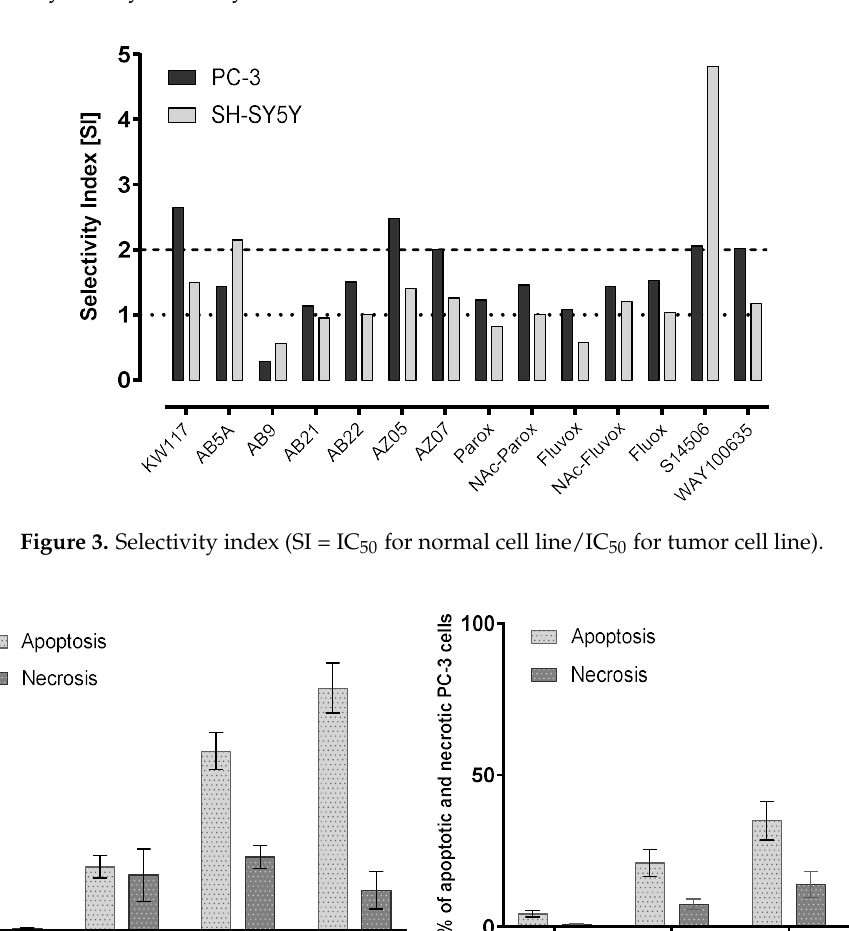
Figure 5. Influence of S14506 on the (1 μM) forskolin-stimulated cAMP level in HEK293 cells that overexpress the 5-HT1AR gene.